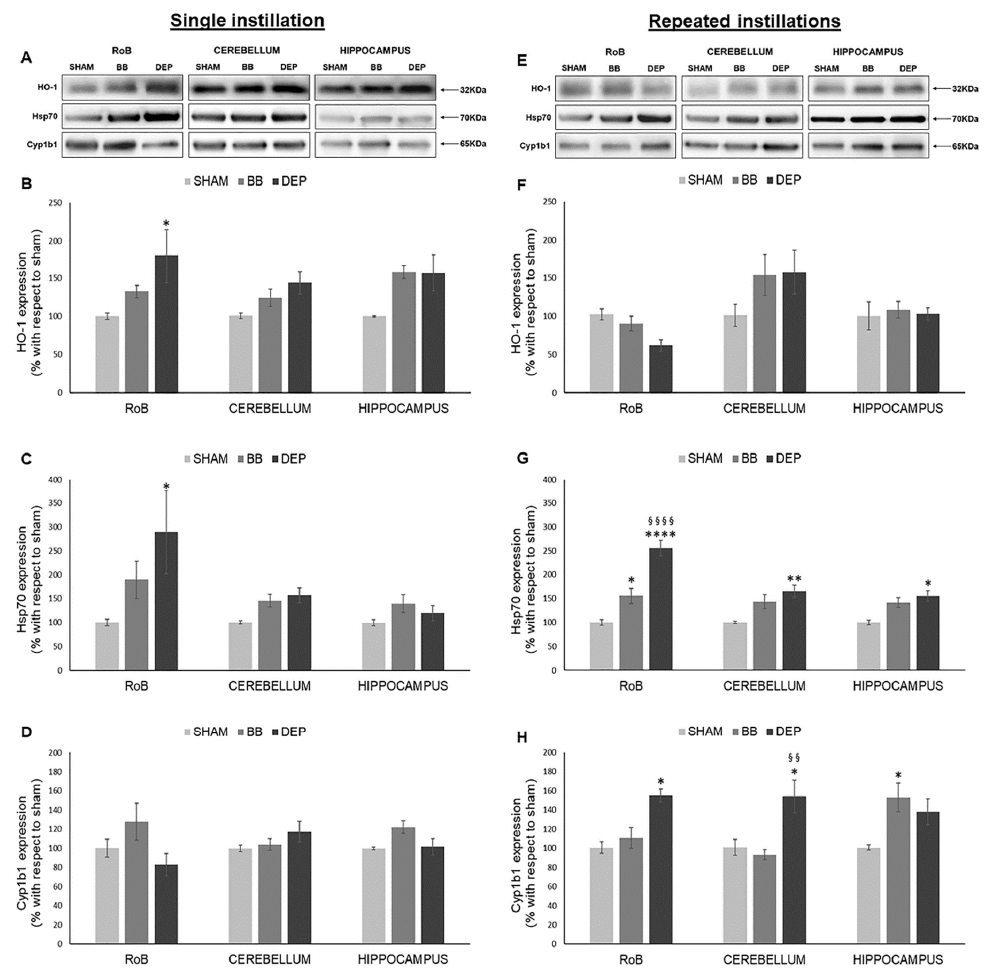
Figure 1. Oxidative stress analysis after single and repeated instillations of biomass burning-derived (BB) particles and diesel exhaust particles (DEP). Representative immunoblotting images of heme oxygenase-1 (HO-1), heat-shock protein 70 (Hsp70), and Cytochrome P450 1b1 (Cyp1b1) analysis in mice after single ( A ) and repeated ( E ) instillations with 50 μg of BB or DEP/100 μL 0.9% NaCl. Histograms display HO-1, Hsp70, and Cyp1b1 expression in mice after single ( B – D ) and repeated ( F – H ) instillations with BB and DEP, with respect to sham. Proteins are normalized to corresponding total proteins revealed by Ponceau in each lane (Figure S3, Supplementary Materials), and the data are expressed as means ± standard error of the mean (SEM) ( n = 6). Statistical differences were tested accordingly by one-way ANOVA followed by Tukey post hoc comparison. * p < 0.05 vs. sham mice; ** p < 0.01 vs. sham mice, **** p < 0.0001 vs. sham mice; §§ p < 0.01 vs. BB-treated mice; §§§§ p < 0.0001 vs. BB-treated mice.